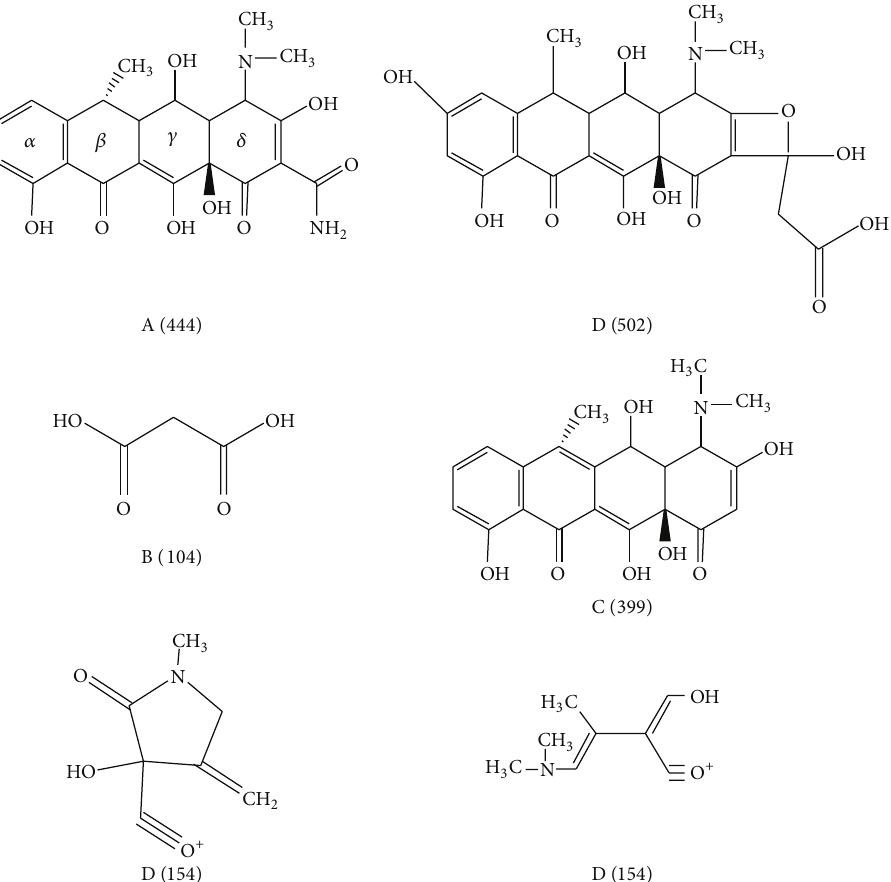
Figure 6: Molecular structures of doxycycline (A) and its degradation products with molar mass of 104 g/mol (B), 399 g/mol (C), and 154 g/mol (D) [9, 11, 13]. (E) Molecular structure of doxycycline degradation product with molar mass of 502 g/mol.